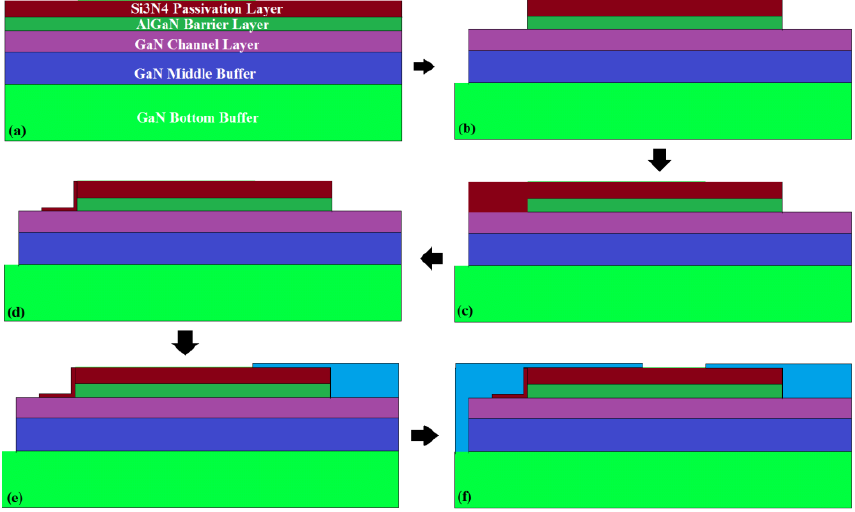
Figure 2. Schematic of the fabrication process steps for the proposed structure.